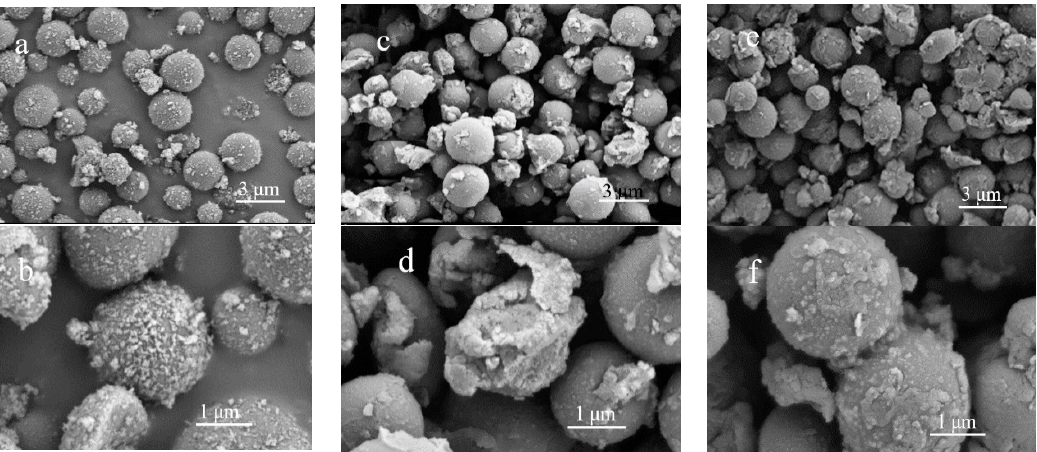
Figure 5. SEM images of pigments with different binders. ( a , b ): PVA coated; ( c , d ): PU coated; ( e , f ): PE-coated fluorescent pigments.